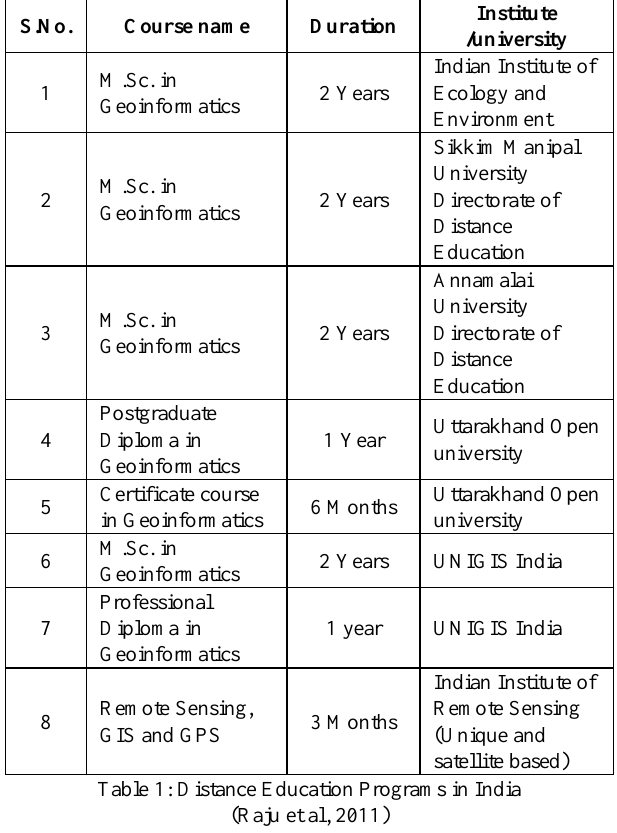
(Raju et al, 2011)